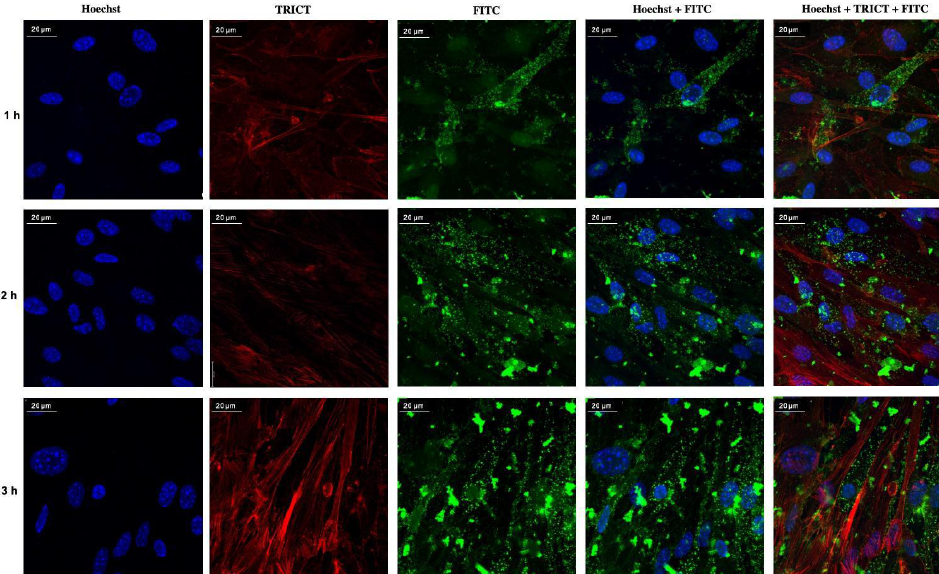
Figure 7. Confocal fluorescence micrograph panel for bEnd.3 monolayers used for permeation studies with FITC-labeled DAL-NP at incubation times of 1, 2, and 3h. Single acquisitions of channels: blue for Hoechst-labeled cell nuclei, red for Tetramethylrhodamine-labeled actin filaments (TRICT), green for the internalized NP (ImageJ software, National Institutes of Health, Bethesda, Maryland, USA, 80 ×